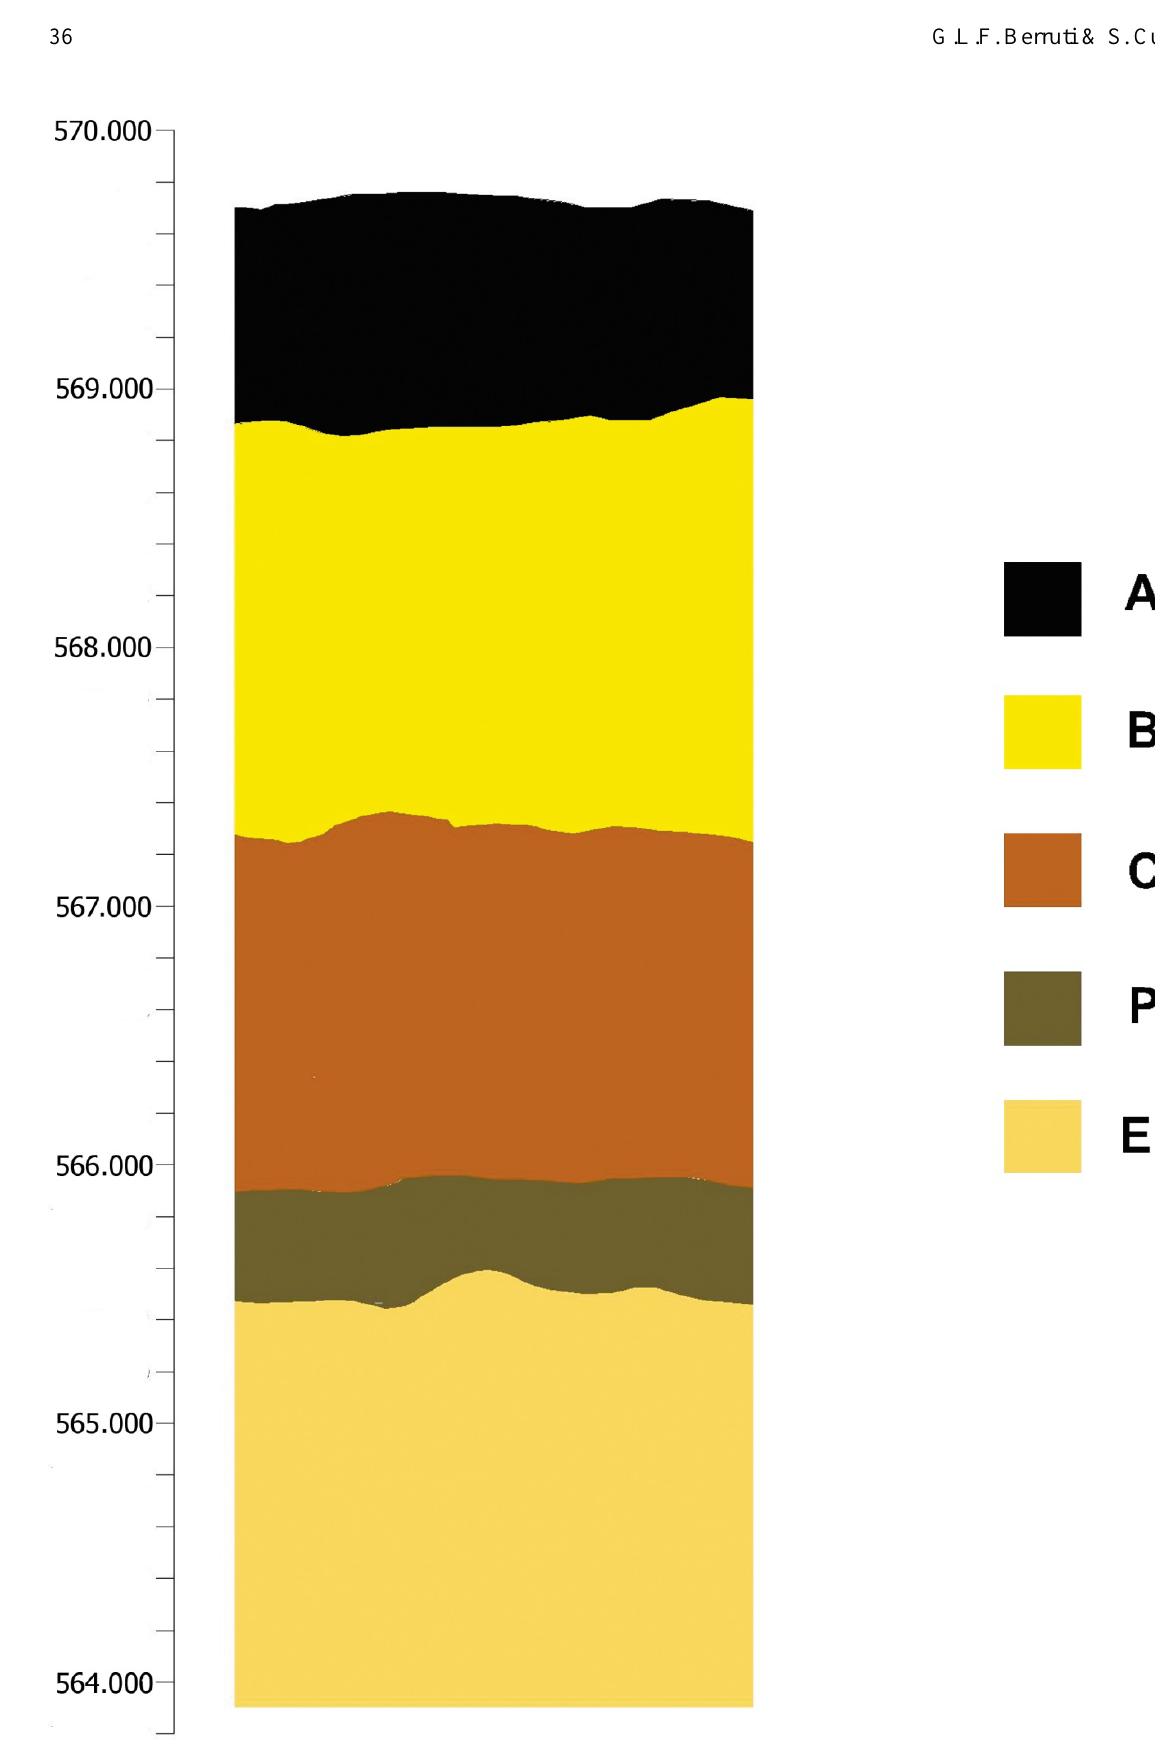
Figure 4. Stratigraphic profile of trench 6: A - Dark clay and fine sand with many organic elements in decomposition; B - Orange clay with brown silt inclusions; C - Orange clay; P - Dark brown clay; E - White and yellow